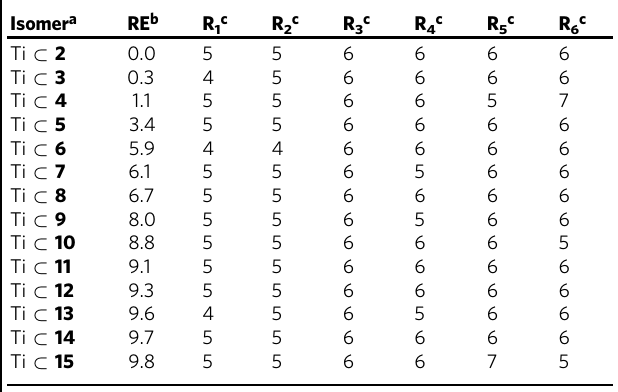
Table 1 Structural patterns in the low-lying isomers of Ti